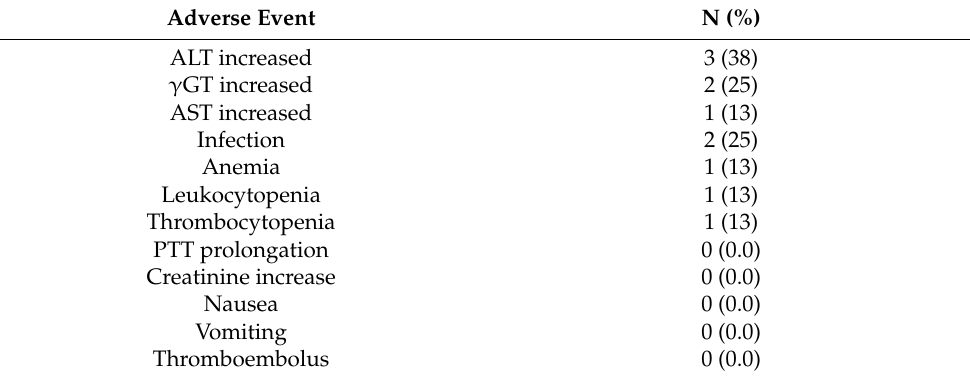
Table 3. Grade 3 or grade 4 adverse